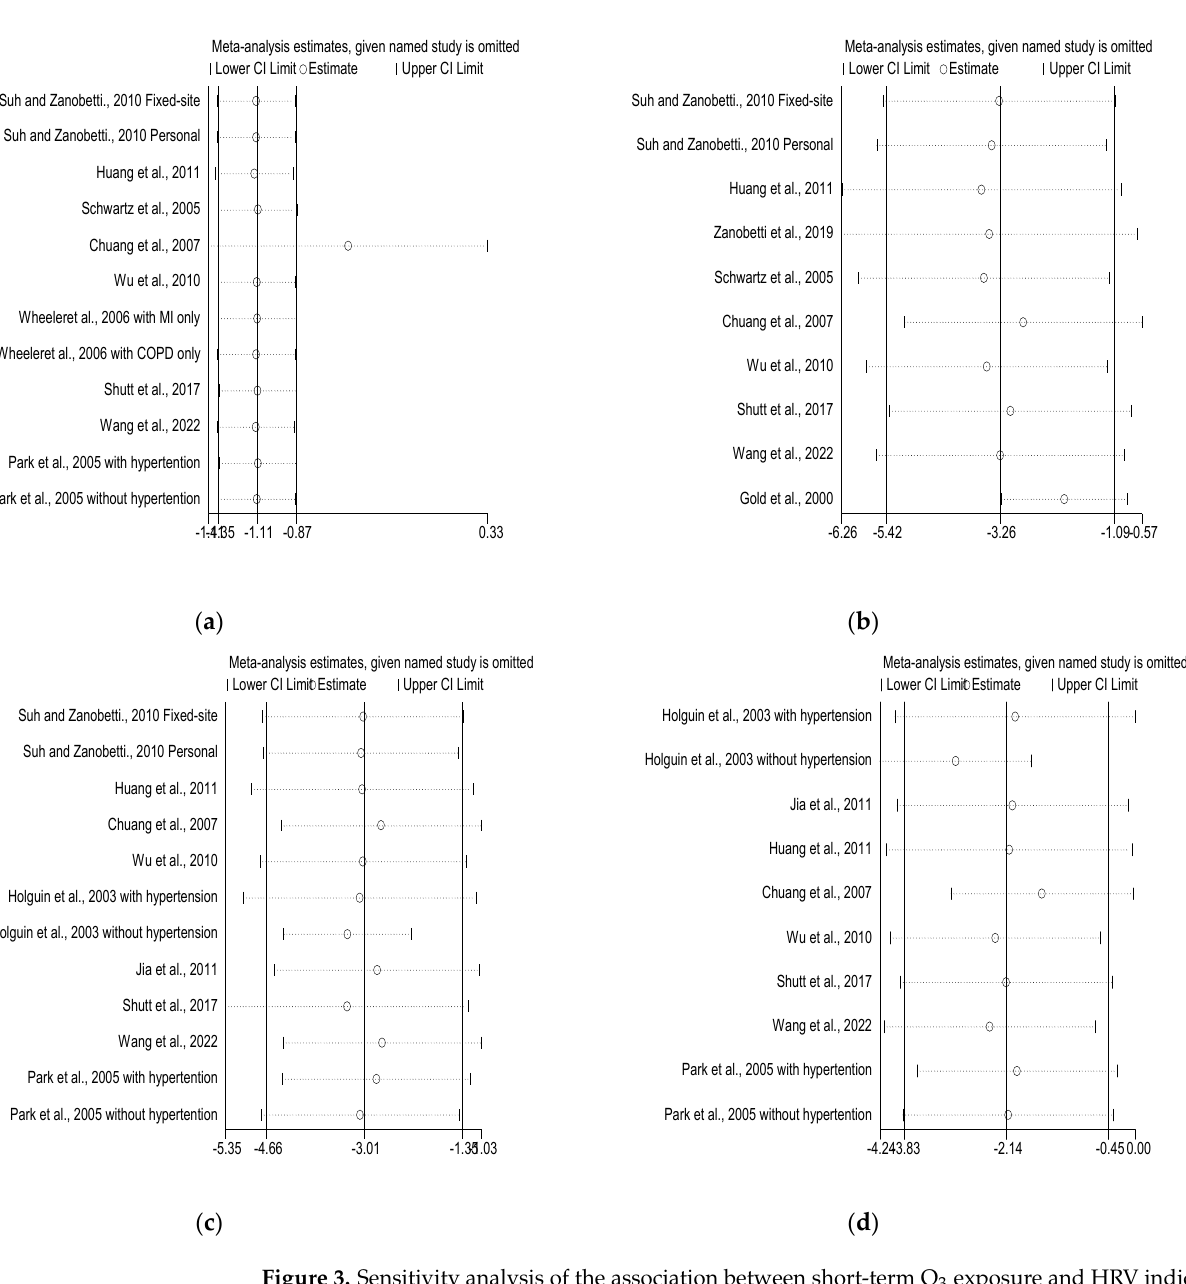
Figure 3. Sensitivity analysis of the association between short-term O 3 exposure and HRV indicators: ( a ) SDNN, ( b ) RMSSD, ( c ) HF, and ( d ) LF [20–32].